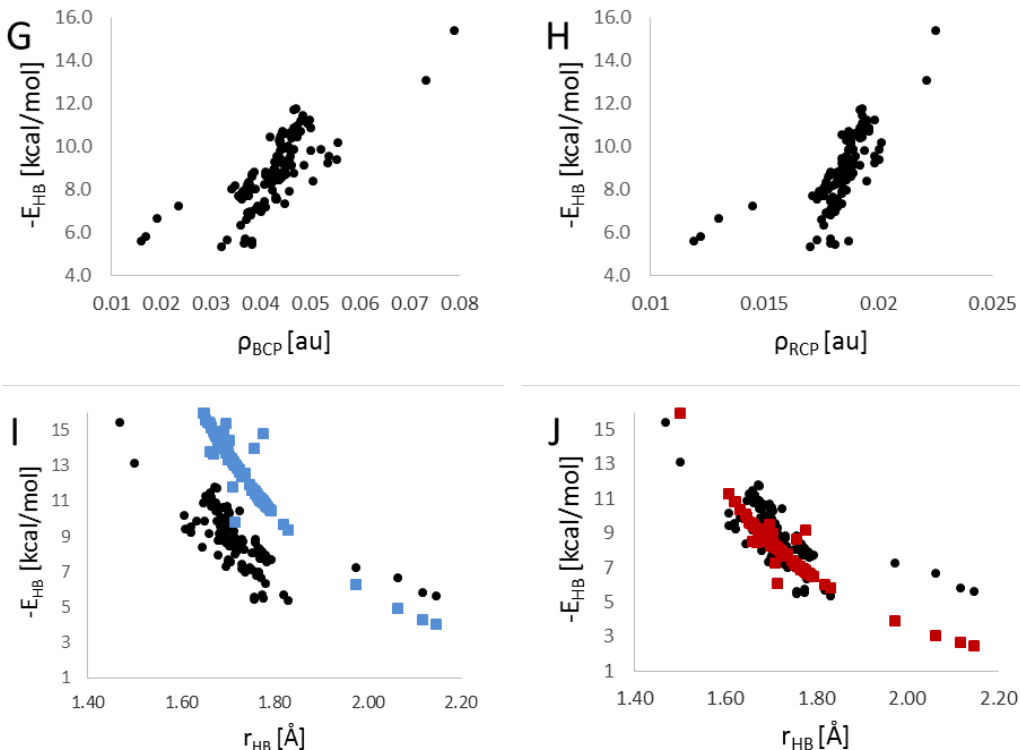
Figure 6. The relations between the calculated energy of intramolecular hydrogen bond E HB (kcal/mol) and some geometrical, spectral and topological parameters of one hundred twenty five investigated hydroxycarbonyl compounds : ( A ) length of H bonding r HB (Å); ( B ) angle of O-H ··· O Ø HB (deg); ( C ) length of O-H bond d OH (Å); ( D ) O ··· O distance d O ··· O (Å); ( E ) frequency of O-H ν OH (cm − 1 ); ( F ) chemical shift of O-H hydrogen δ H (ppm), ( G ) electron density in hydrogen bond critical point ρ BCP (au); ( H ) electron density in ring critical point ρ RCP (au); ( I ) comparison of E HB values calculated in the framework of this study and E HB calculated based on Espinosas’ equation ( E HB = 1 2 𝑉 𝐵𝐶𝑃 ) [27] in relation to length of H bonding r HB (Å ); ( J ) comparison of E HB values calculated in the framework of this study and E HB calculated based on Afonins’ equation ( 𝐸 𝐻𝐵 = 0.31 × 𝑉 𝐵𝐶𝑃 ) [28] in relation to length of H bonding r HB (Å ).